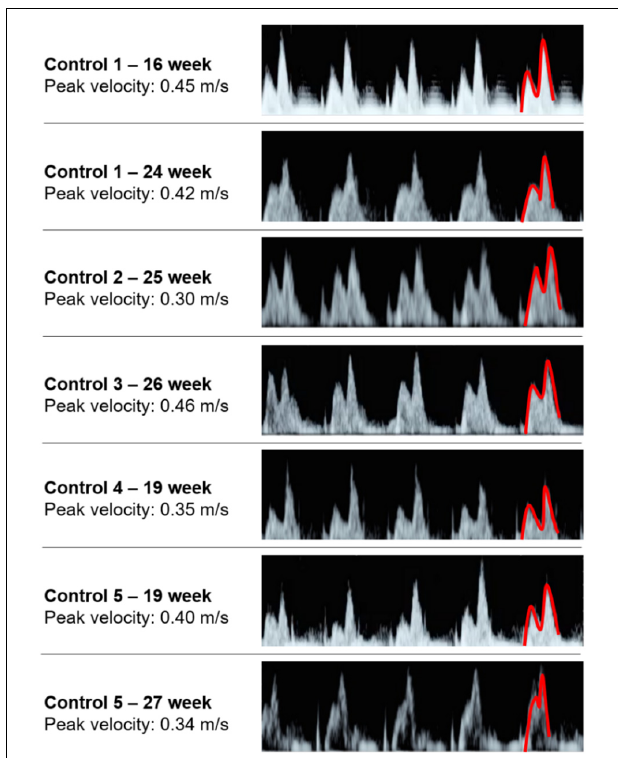
FIGURE 6 | Comparison of mitral valve peak flow velocities considering various gestational stages. The black line is determined by curve fitting using linear